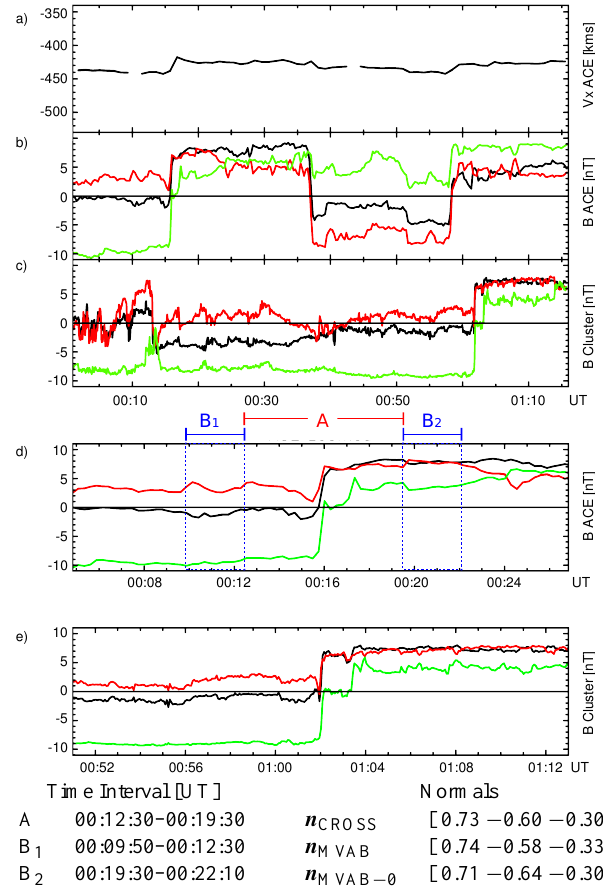
Fig. 2. Example of an IMF discontinuity observed by both ACE and Cluster on 30 March 2003. The panels show: (a) the X compo- nent of the solar wind speed measured by ACE. (b) magnetic field at ACE, (c) magnetic field at Cluster. (d, e) Same as panels (b) and (c), but zoomed in and centered around the main magnetic field ro- tation. In panel (d), the marked interval A is the time segment used to calculate the IMF orientation as described in the Sects. 3.2.2 and 3.2.3. Similarly, B 1 , B 2 are the corresponding upstream and down- stream time intervals used for the cross product calculation – see Sect. 3.2.1. Black, red and green line colors indicate the X, Y, re- spectively Z GSE components of the magnetic fields. The bottom part of the figure shows the exact time intervals used and the nor- mals obtained for this particular case.